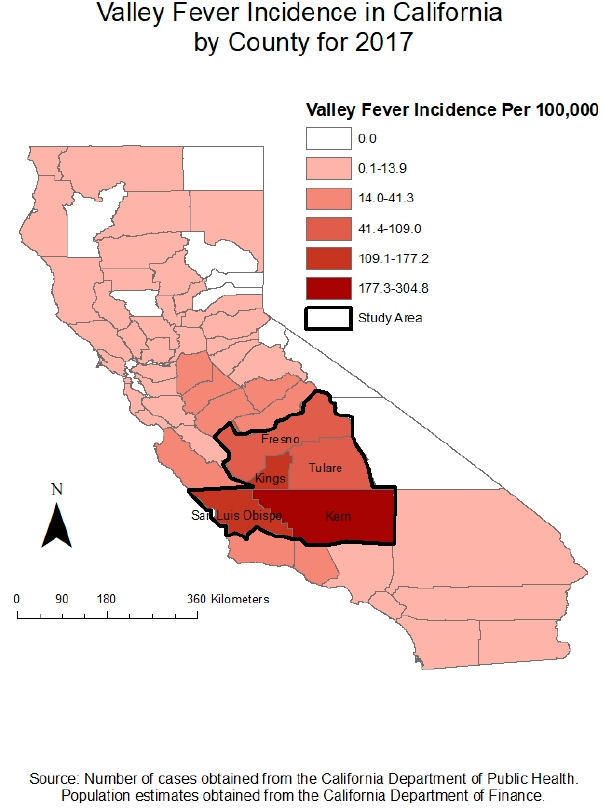
Figure 1. Valley Fever incidence in California by county for 2017 .